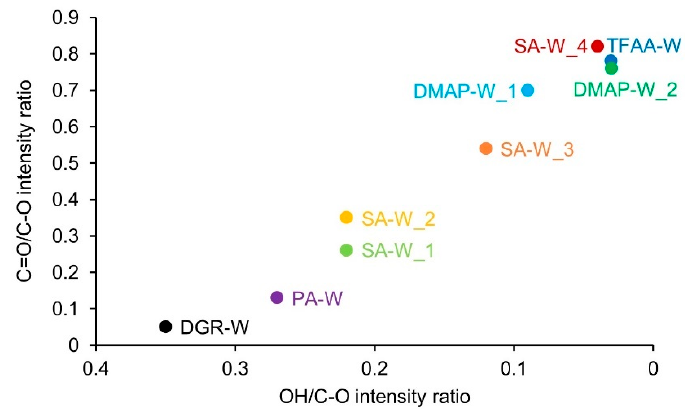
Figure 3. Intensities of the peaks at approximately ( a ) 1060, ( b ) 3340, and ( c ) 1740 cm − 1 in the IR spectrum of the TFAA-W propionylated wood.